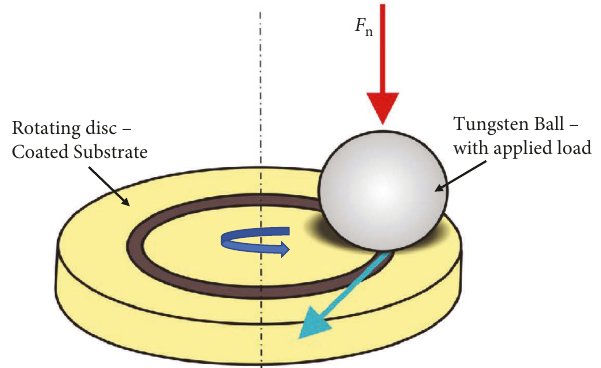
Figure 7: Schematic illustration of the ball-on-disc wear test process following the ASTM standard (ASTM G133-05)